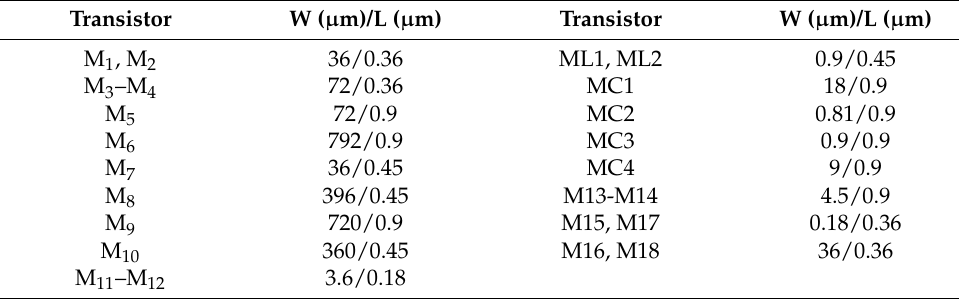
Table 1. Aspect ratio of the used transistors.